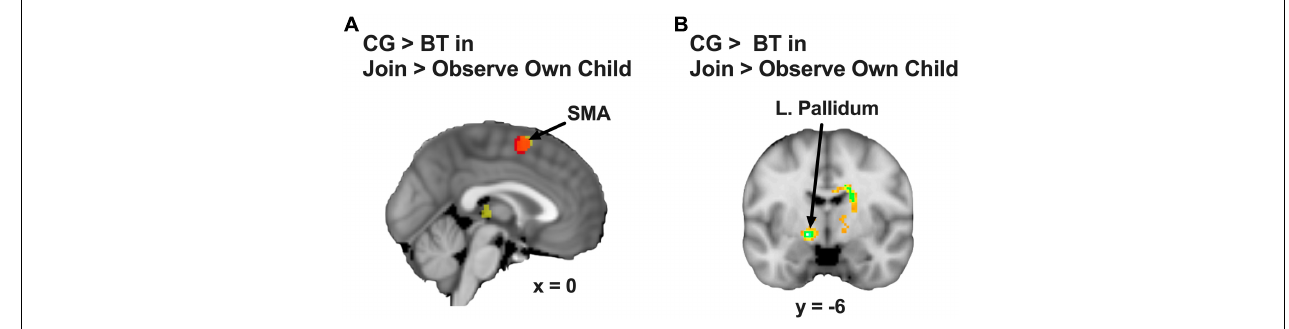
FIGURE 4 | (A) The SMA (the red area indicates the overlap with the Figure 2 ) and (B) the left pallidum showed CG > BT group difference in Join > Observe of Own Child differential neural response. The statistical map is presented with an activation threshold of p = 0.005, uncorrected.